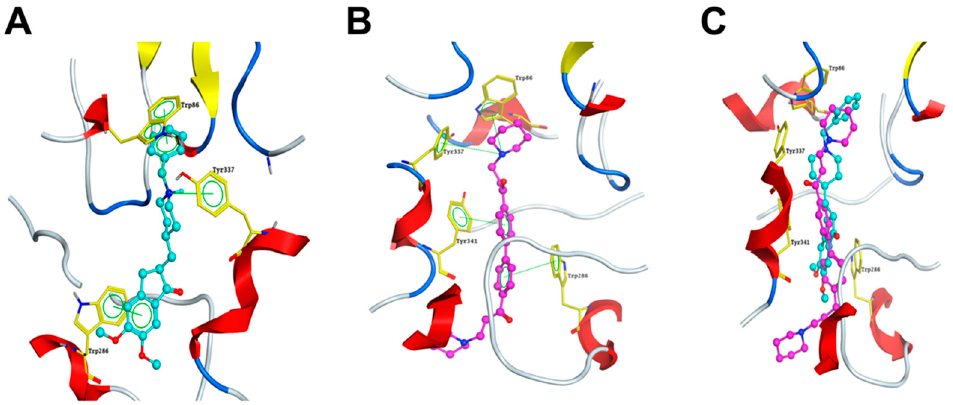
Figure 8. The binding mode of DL0410 and donepezil in the active site of AChE (PDBID: 4EY7). Compounds are displayed in ball-stick model, with carbon of donepezil in cyan ( A ) and carbon of DL0410 in purple ( B ); and the binding residues are shown in stick model with carbon in yellow; ( C ) The superposition of DL0410 and donepezil in the the active site of AChE. Nitrogen is shown in blue, and oxygen is in red.